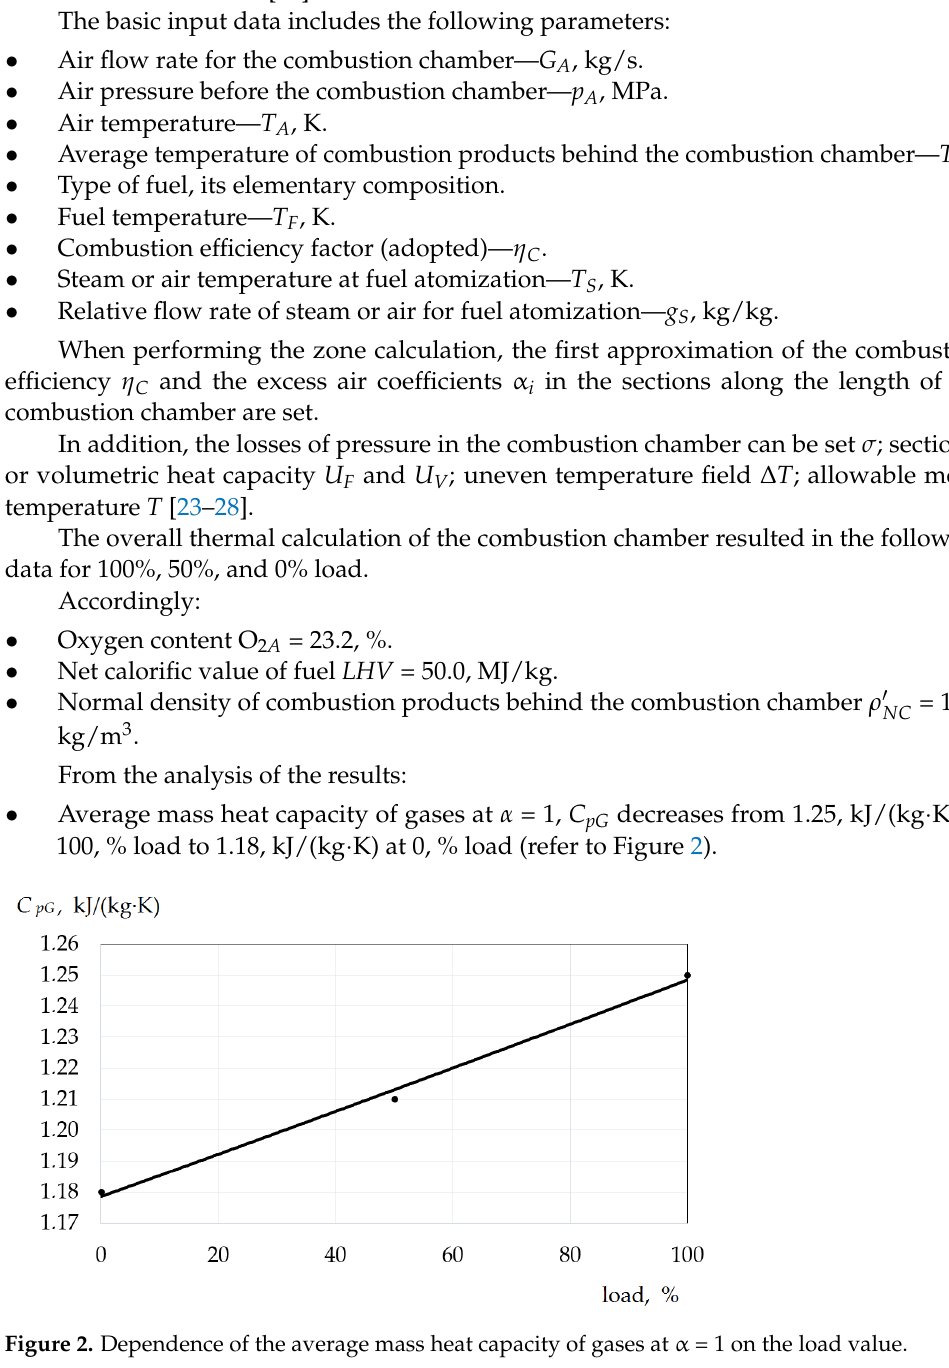
Figure 3. Dependence of the excess air ratio behind the combustion chamber on the load value. •